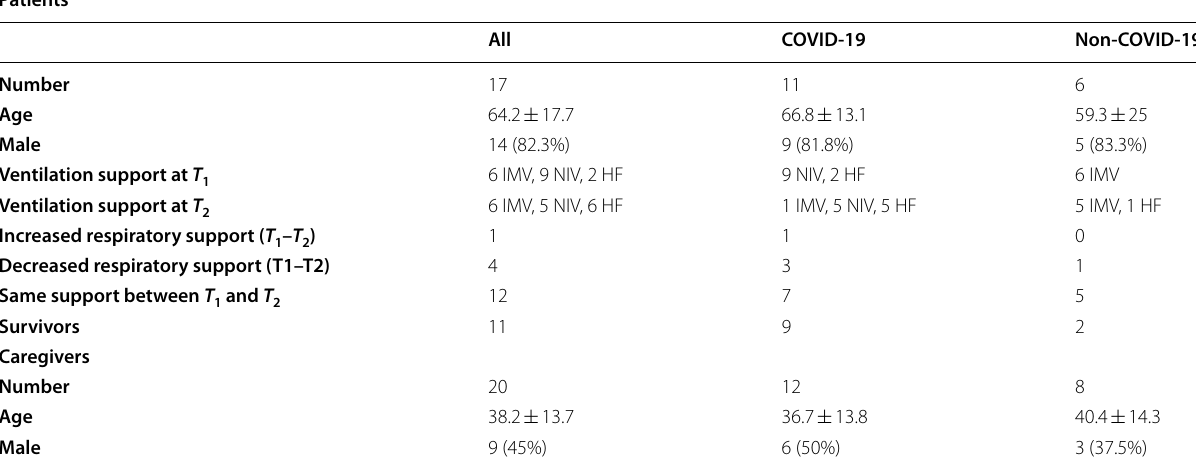
Table 1 Demographics of patients and caregivers